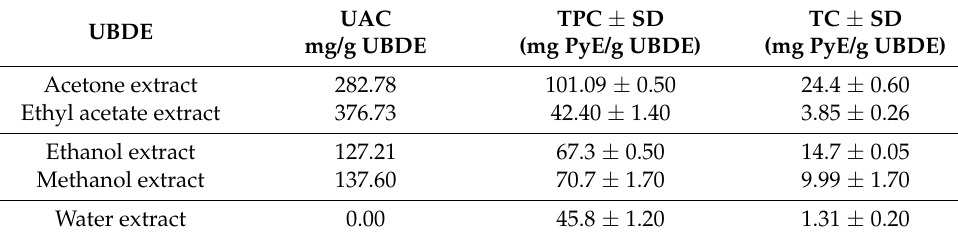
Figure 1. The chromatograms of usnic acid standard ( a ) and UBDE in different solvents ( b – f ); the baseline marked lines represent the peak integration. Table 2. The metabolites content of UBDE in different